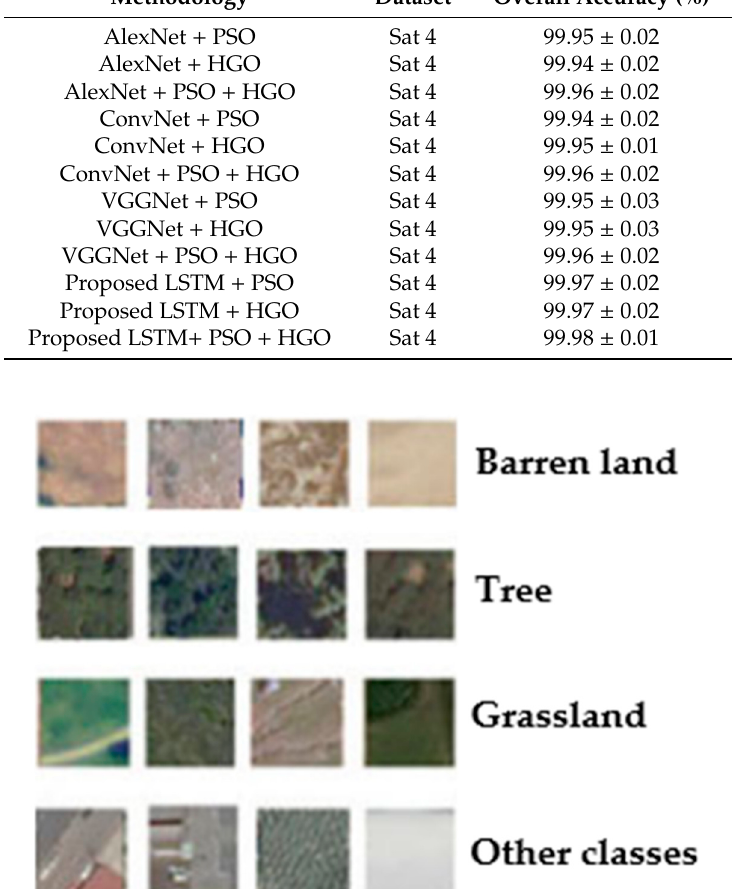
Figure 10. Sample image patches of Sat 4 dataset.